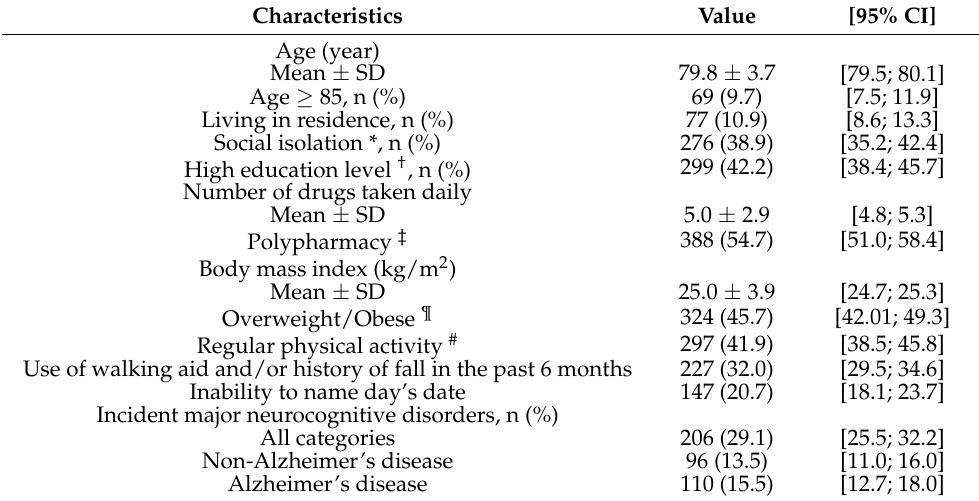
Table 1. Participants’ baseline characteristics and incident major neurocognitive disorders (n =